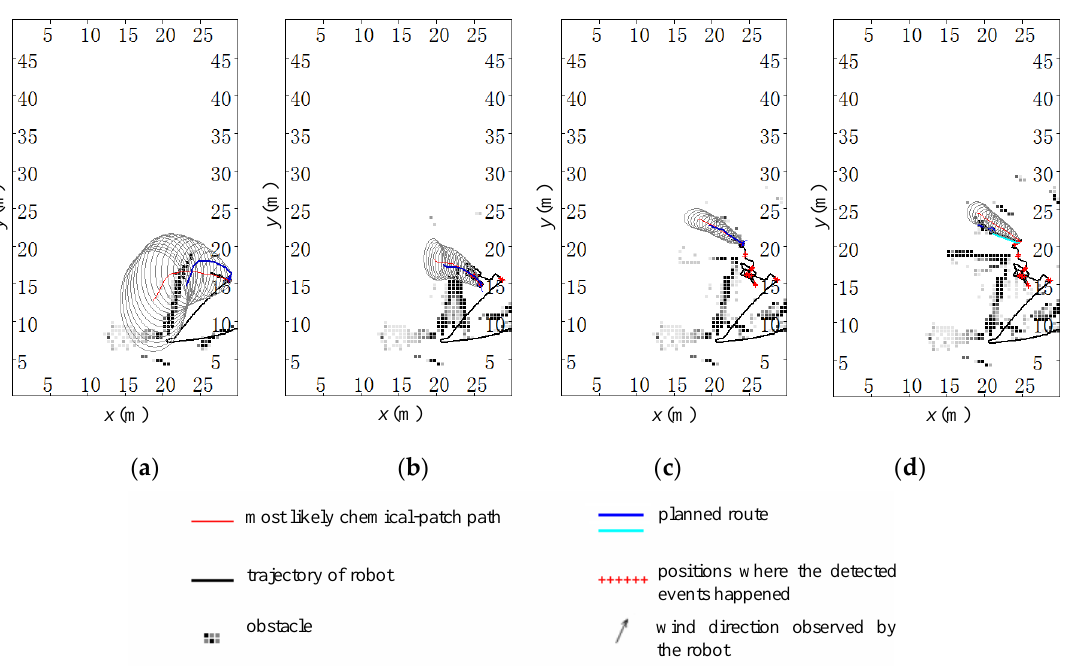
Figure 12. Four reconstructed scenes during the CSS process in the square field. ( a ) t = 62.0s, the robot was at (28.81, 15.41) m. ( b ) t = 132.5s, the robot was at (25.80, 15.07) m. ( c ) t = 173.0s, the robot was at (24.06, 20.28) m. ( d ) t = 196.0s, the robot was at (21.01, 22.12) m. The unit of each subgraph is meters. The total tracing time (excluding the chemical-clue-finding time) was 134.0 seconds.